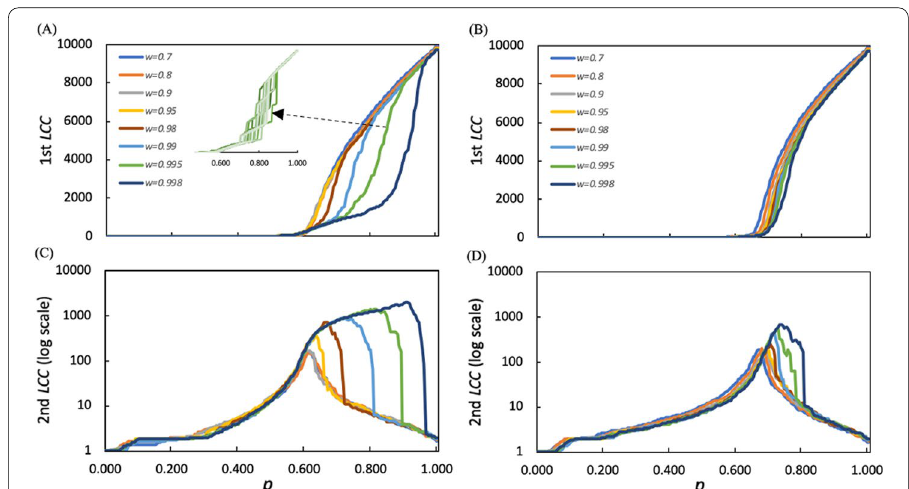
Fig. 4 Averaged simulation result for modular networks generated from BA network with N and (cid:31) k (cid:30) 4 with different value of rewiring probability w : Size of the first largest connected component (1st = LCC ) and the second largest connected component (2nd LCC ) as a function of the occupation probability p when attacked by IB ( A and C , respectively) and ID ( B and D , respectively). In ( A ), an insert showing 20 single simulations of the network with rewiring probability of w